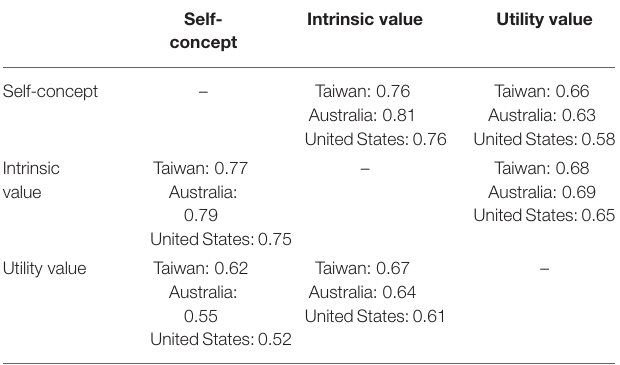
TABLE 4 | Estimated standardized covariance among science motivational